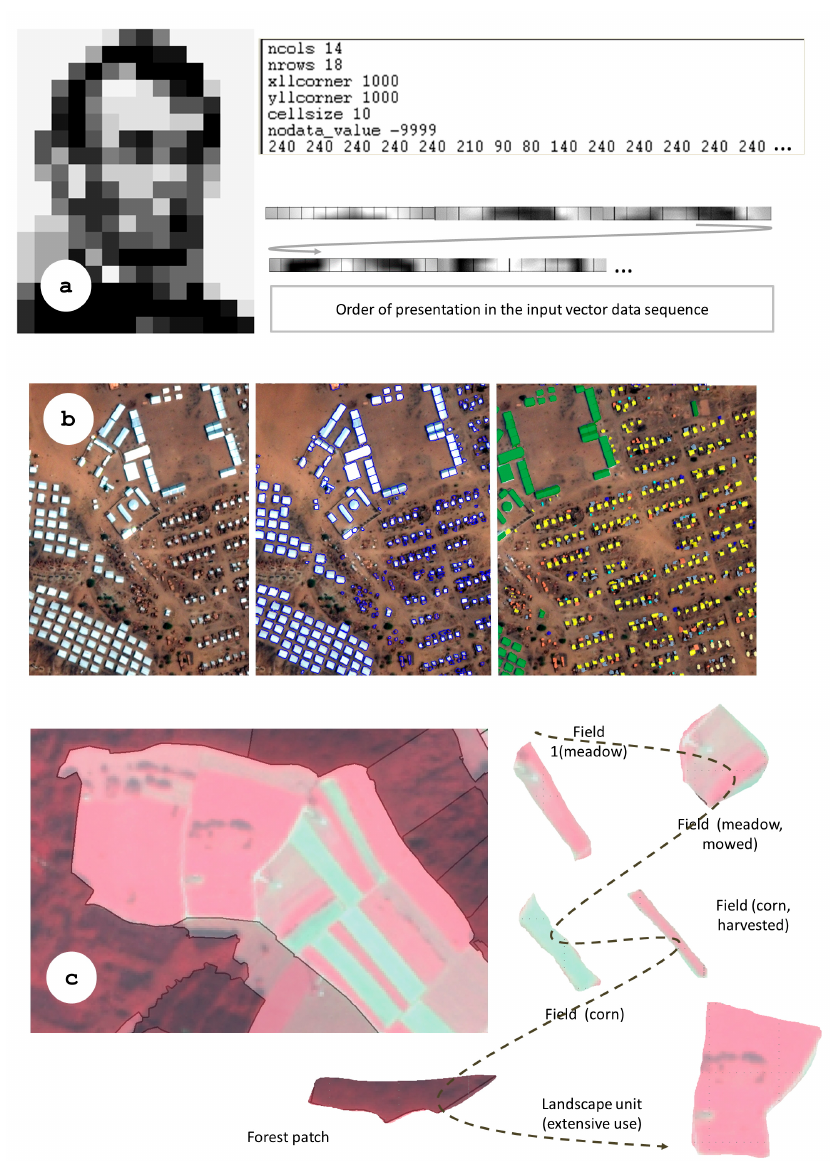
Figure 2. From 1D to 2D image analysis, a recognizable (pixelated) 2D image ( a ) of Abraham Lincon (at left) is transformed into the 1D vector data stream shown on the right. This 1D vector data stream, either pixel-based or local window-based, means nothing to a human photointerpreter. This (out-of-context) 1D vector data stream is what the inductive classifier actually ‘sees’ when analysing the (2D) image at left. ( b ) Similarly, the linear sequence of segmentation and classification—often applied in standard GEOBIA workflows—may su ffi ce for singular feature extraction tasks such as classifying dwellings in a refugee camp, but falls short ( c ) when modelling ‘composite objects’ such as ecologically relevant complexes, e.g. a mixed-arable land as shown